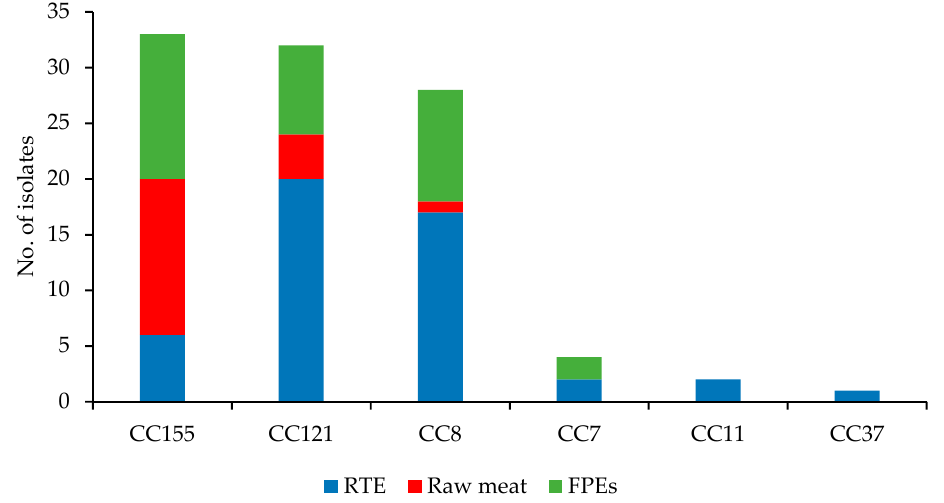
Figure 1. Distribution of clonal complexes (CCs) among of 100 L. monocytogenes isolates tested (RTE, ready-to-eat meat; FPEs, food production environments).